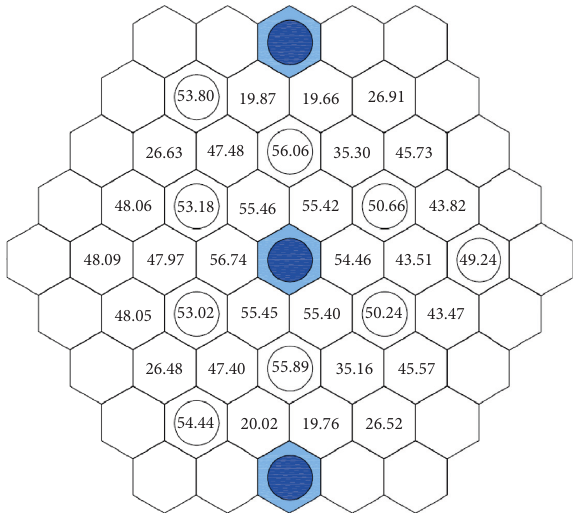
Figure 8: Burnup distribution in percent loss of 235 U at the EOC of the MPRR core.